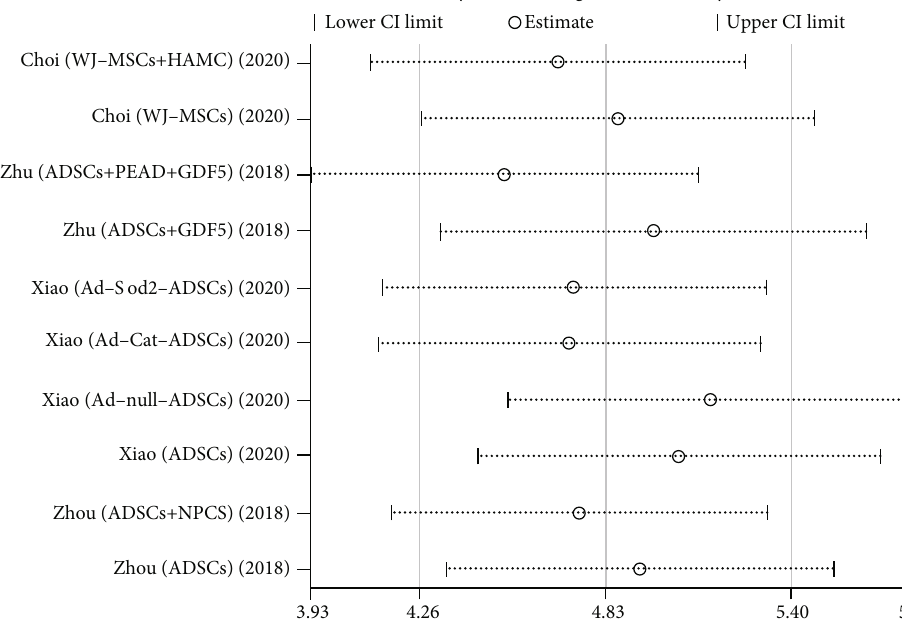
Figure 15: Sensitivity analysis of MRI index.